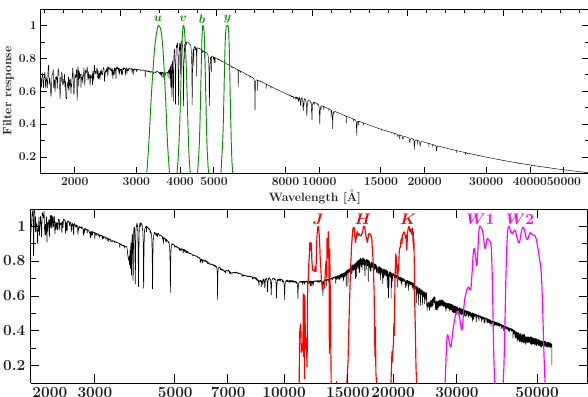
Figure 1. Response function for optical (Strömgren, top) and infrared (2MASS and WISE, bottom) photometric systems. Synthetic SEDs are plotted as F λ λ 3 . In the top panel a single SED is plotted, while for the bottom panel a composite SED is used. Both are scaled for comparison to the transmission